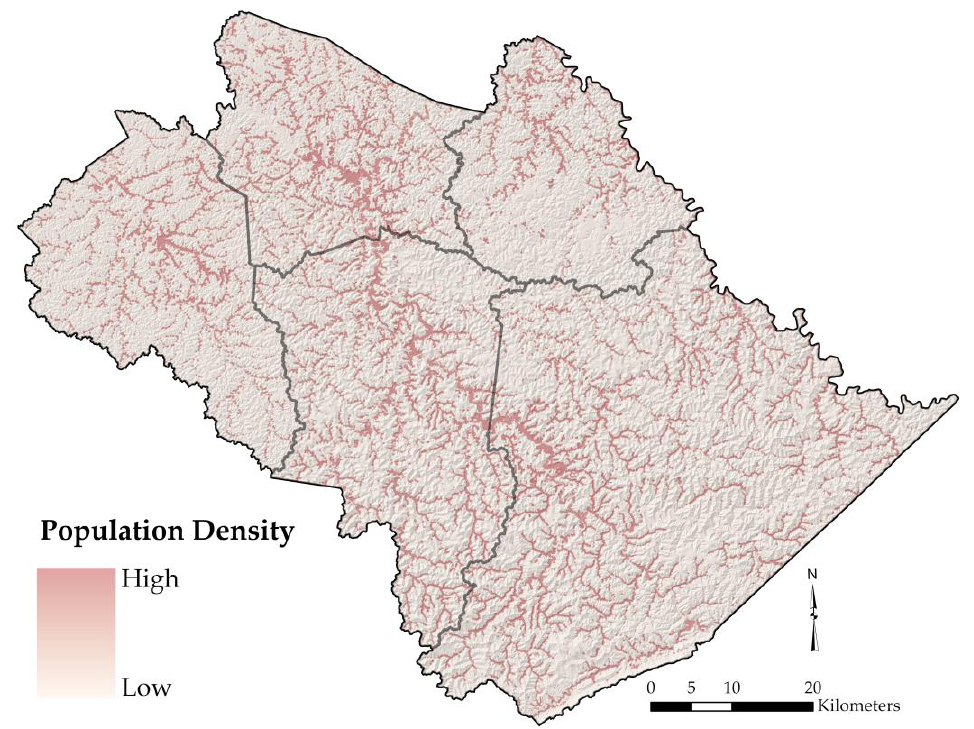
Figure 6. Kernel density map of population for the Big Sandy Area Development District. The low to high range of density classification represents the units of number of points per square map